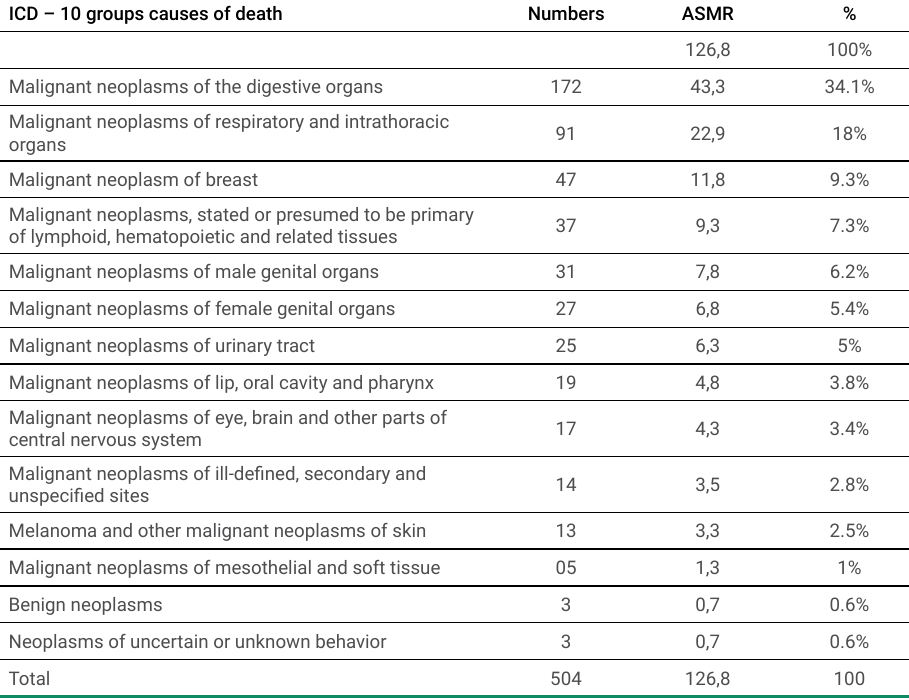
Table 4. Causes of death in the city of Piracicaba according to ICD – 10